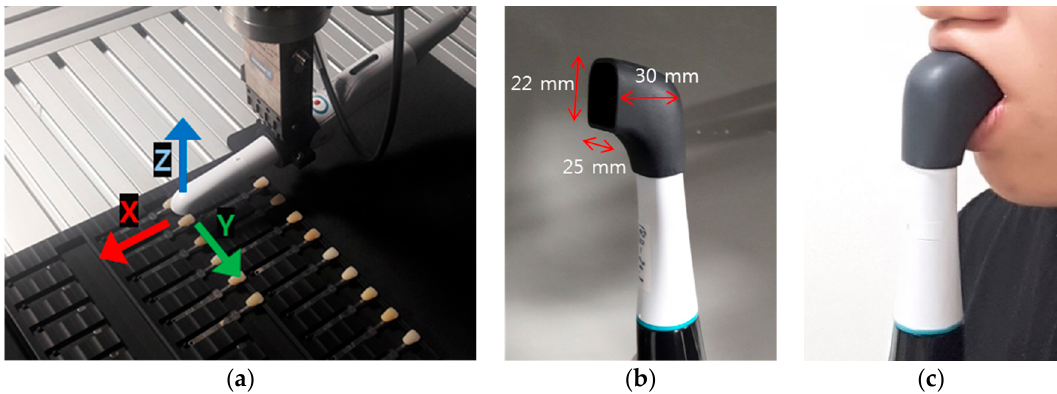
Figure 2. ( a ) Experimental setup for color measurement using the 3D shade guides ( b ) Head cap to block the light from outside ( c ) Clinical application of the developed digital shade-matching device.